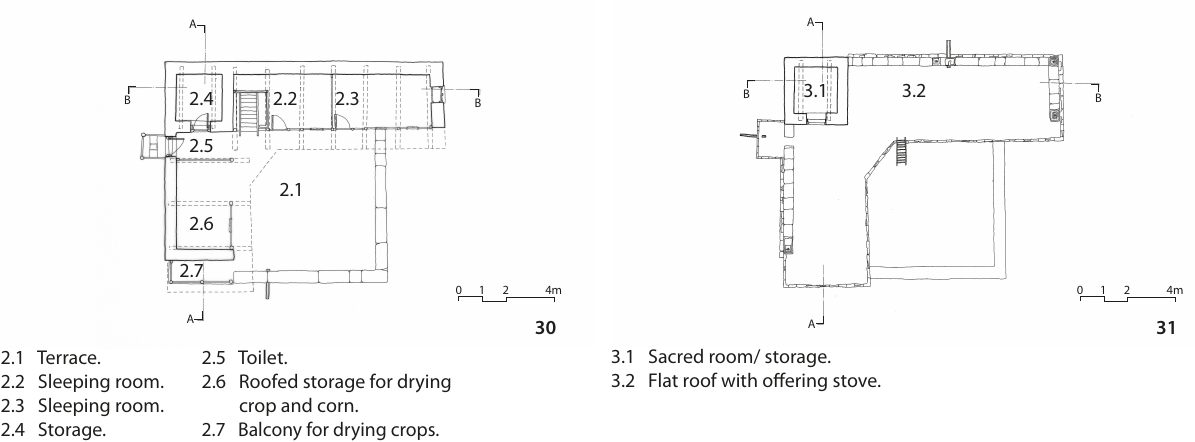
Figure 31 Third floor plan of the farmhouse in Gyalrong (Source: the